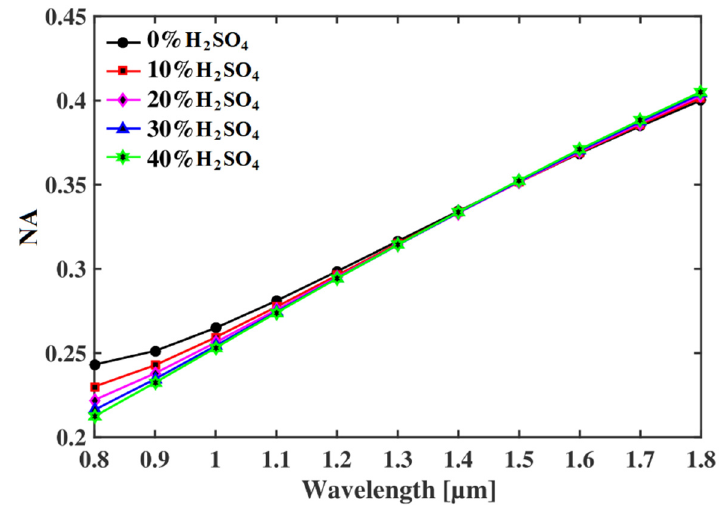
Figure 6. NA of the proposed sensor as a function of operating wavelength.